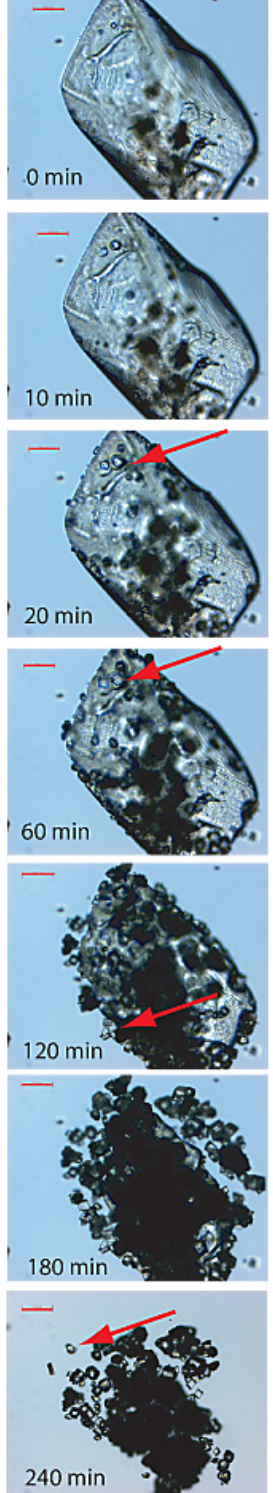
Fig. 5. Ikaite crystal dissolution during melting of sea ice over 240min. Arrows point at smaller sub-units of crystals (also ikaite) that emerge during melting. Scale bar is